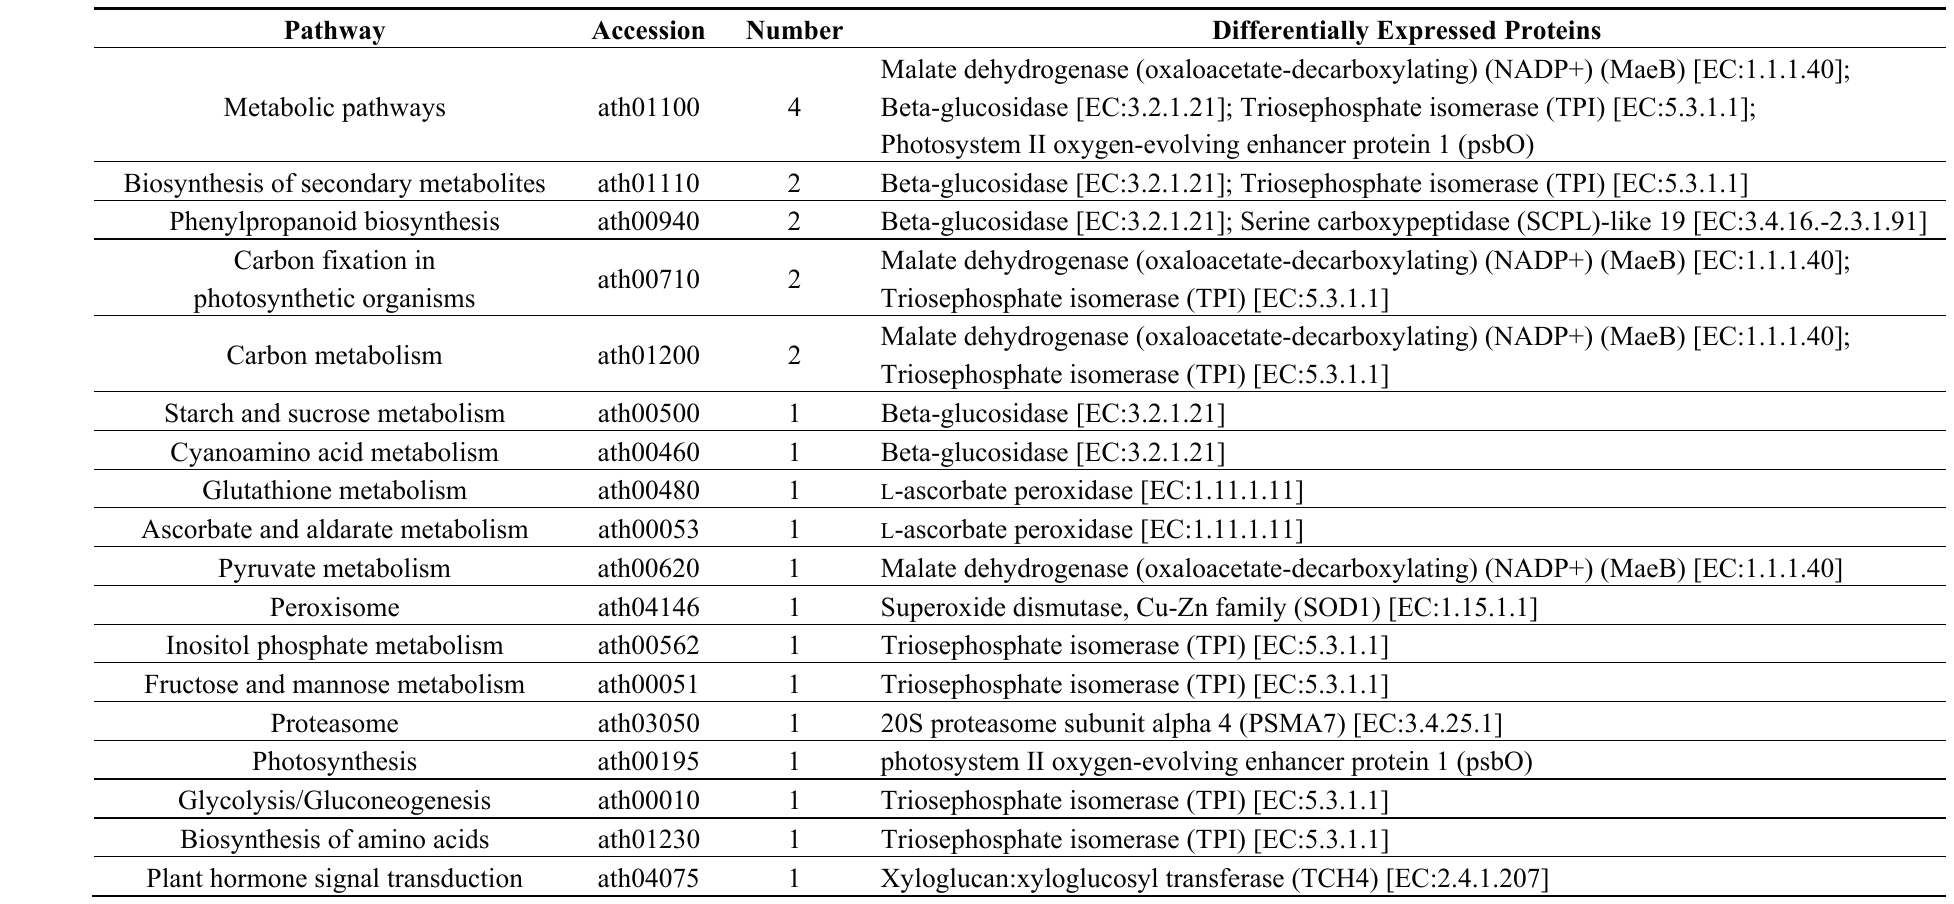
Table 2. Pathways of the differentially expressed proteins of the labellum and lateral petal as referenced against the known Arabidopsis thaliana homologs in Kyoto Encyclopedia of Genes and Genomes (KEGG)